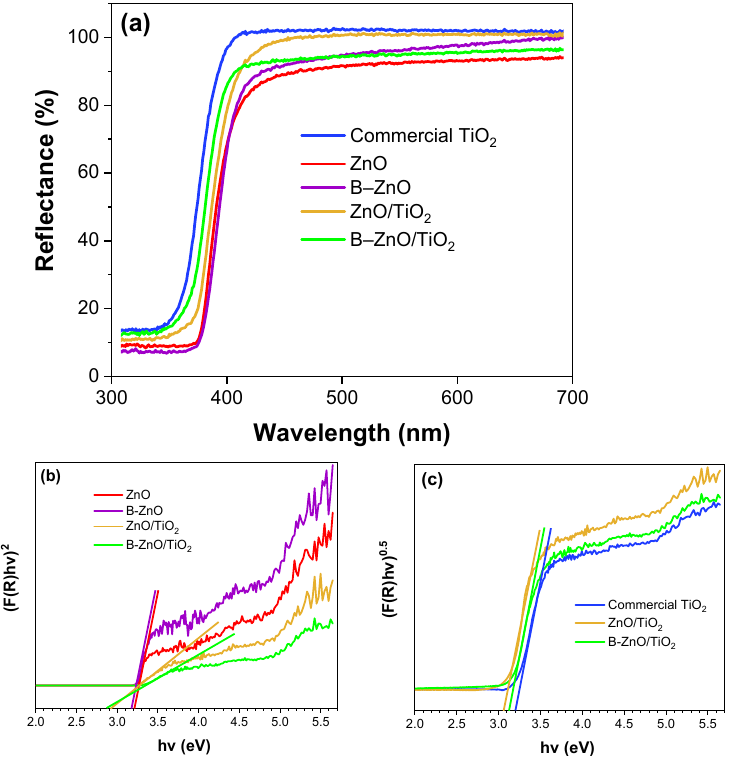
Figure 4. ( a ) UV-Vis DRS patterns of TiO 2 , ZnO, B–ZnO, ZnO/TiO 2 , and B–ZnO/TiO 2 ; Tauc plot for ( b ) direct and ( c ) indirect transitions.